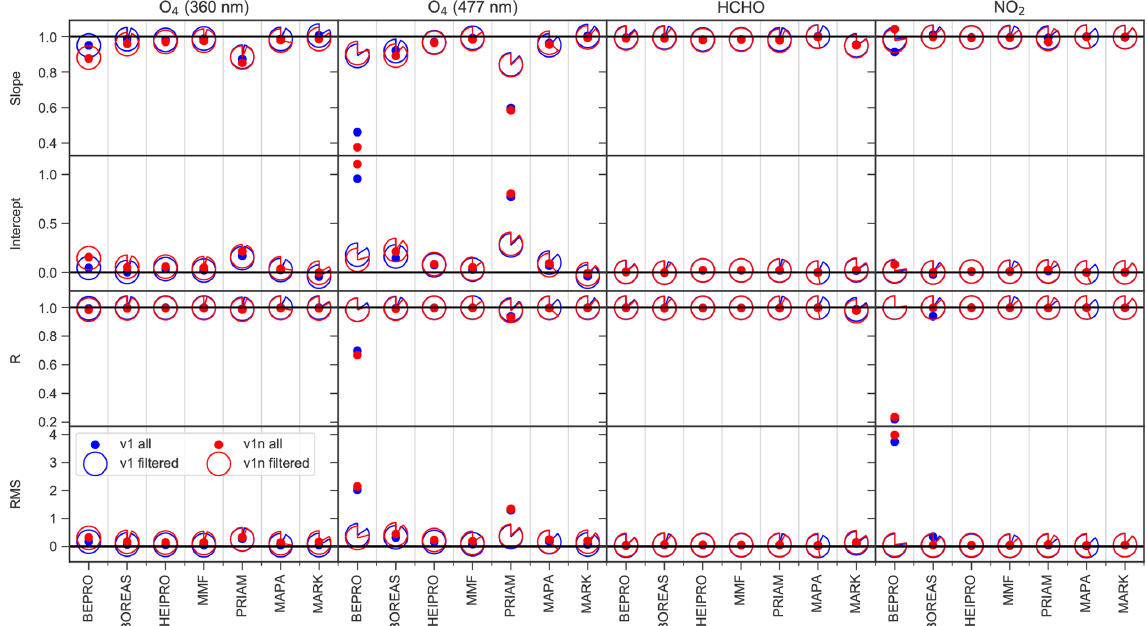
Figure 10. Slope, intercept, regression coefficient, and RMS of the dSCD correlation. Each of the circular symbols for the filtered data represents a pie chart that quantifies the fraction of data flagged as valid. RMS and intercept values are in units of 10 43 molec 2 cm − 5 for O 4 and 10 17 moleccm − 2 for HCHO and NO 2 . Cloud and fog scenarios (AER8, AER9, AER10) are excluded from the regression